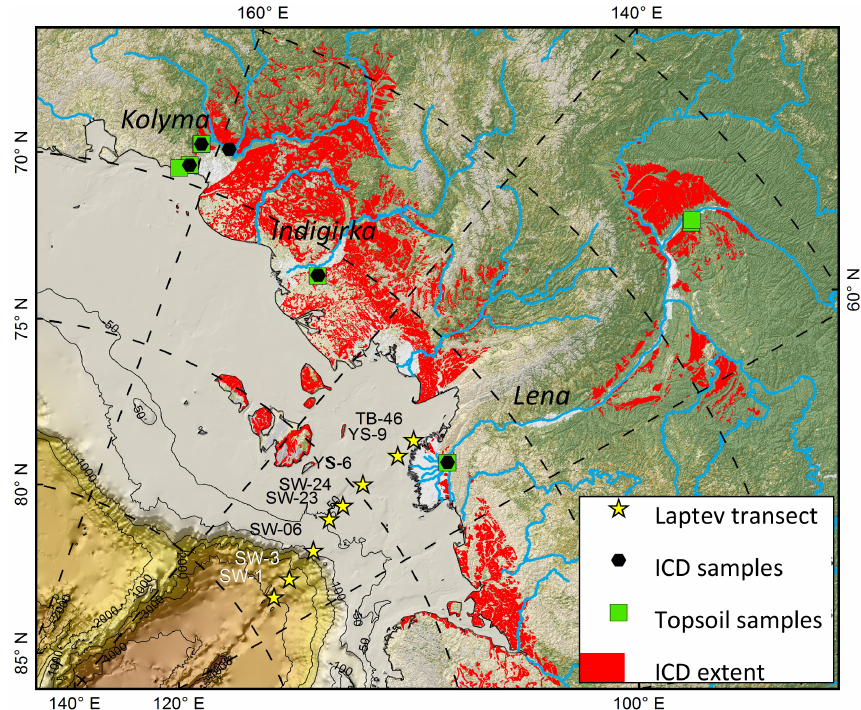
Figure 1. Map of coastal northeast Siberia showing the extent of ice complex permafrost (ICD PF, red) overlaid with the location of ice complex ( n = 9; black diamonds) and topsoil samples ( n = 9; green squares). The shelf-slope Laptev Sea transect is shown with yellow